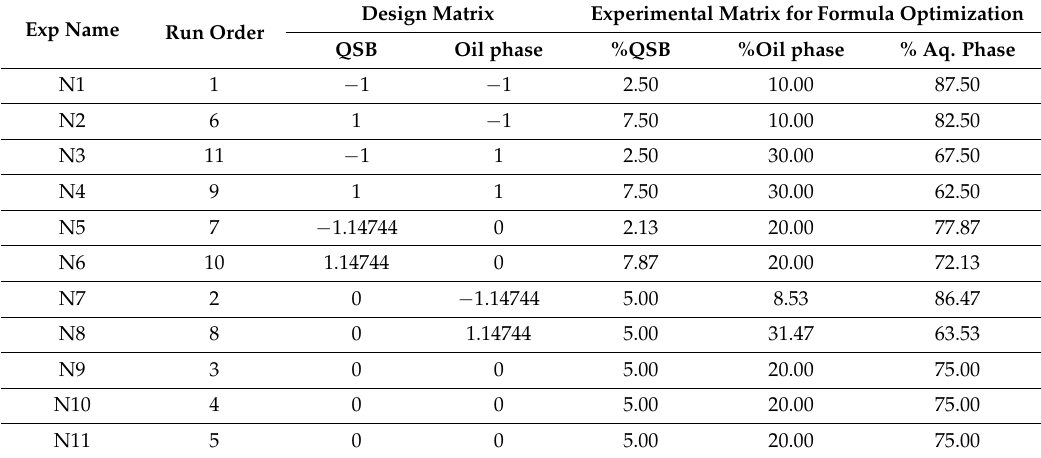
Table 2. Design of experiments (QSB-stabilized emulsion